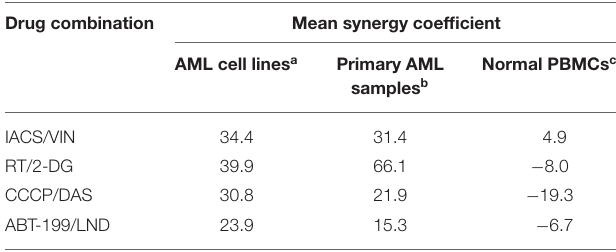
TABLE 5 | Comparison of the effect of selected mitocan combinations on AML cell lines, primary AML samples, and healthy PBMCs. Drug